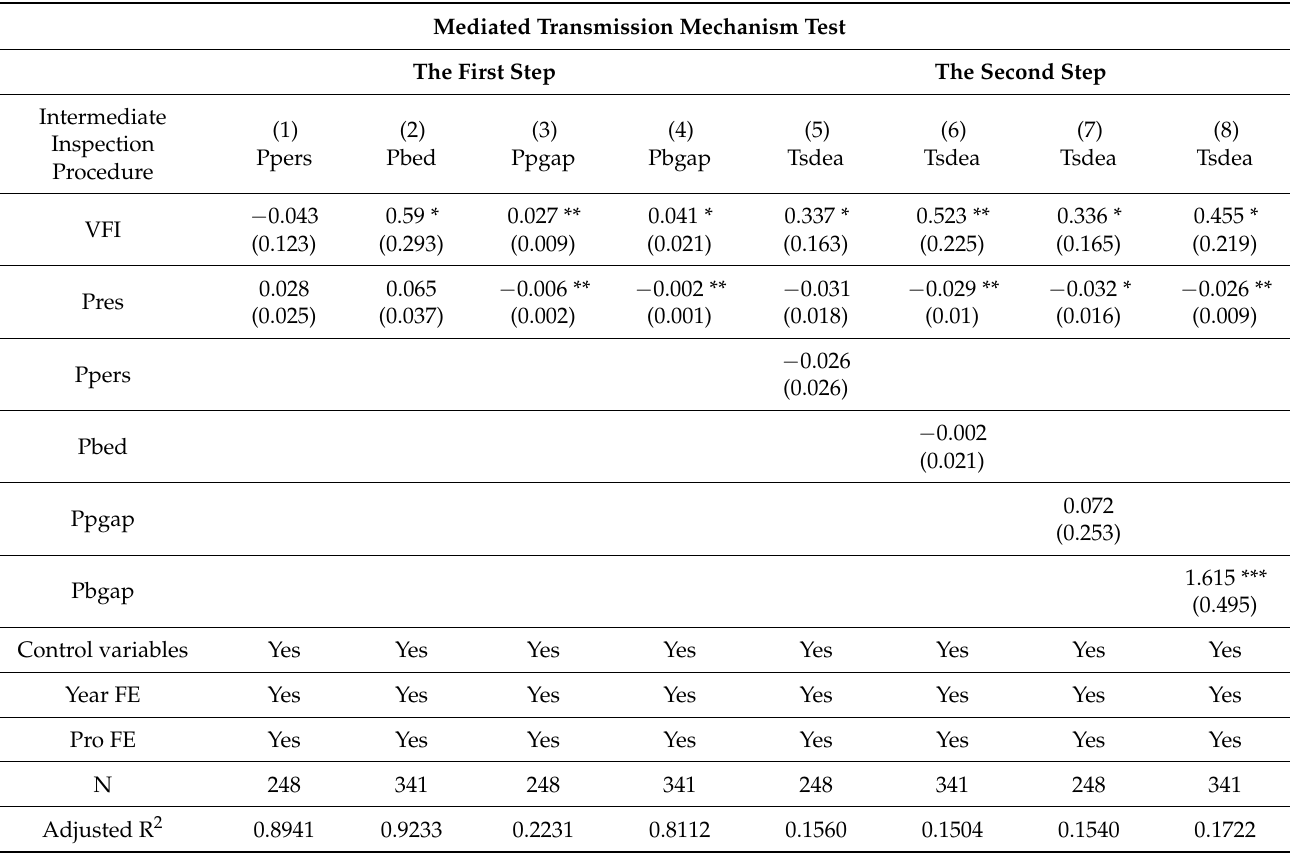
Table 6. The path of vertical fiscal imbalance in China to improve fiscal health expenditure